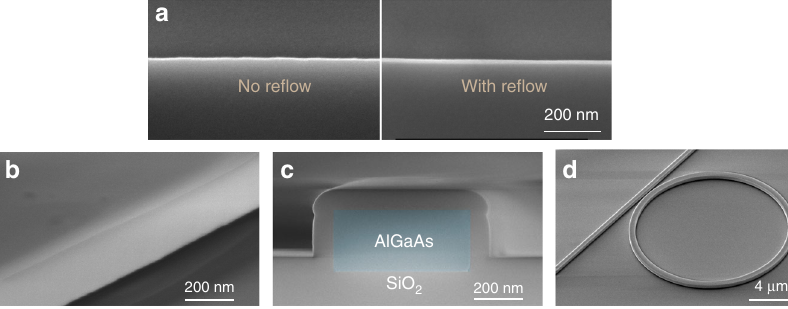
Fig. 2 SEM images. a Top view of the SiO 2 hard masks with and without re fl ow applied after the lithography process. b Sidewall of the waveguides. c Cross section of the waveguide after passivation and a thin layer of SiO 2 deposition; the AlGaAs core is highlighted with false color (blue). d A ring A schematic drawing of the fully etched AlGaAsOI waveguide